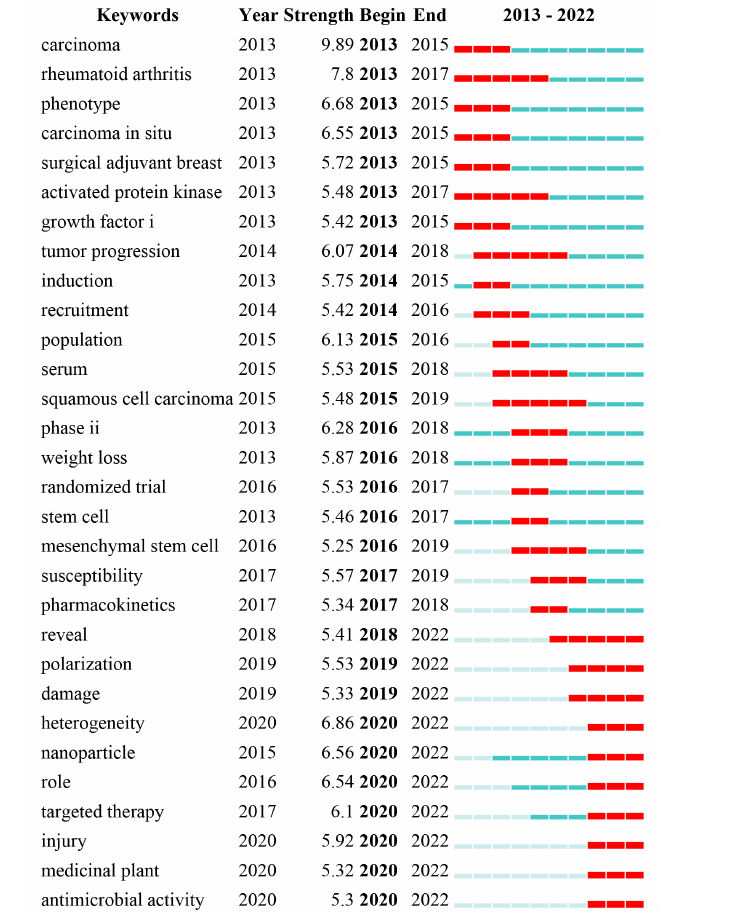
FIGURE 8 In this visualization of CiteSpace ’ s analysis of the top 30 keyword explosions, “ strong ” denotes the magnitude of the explosion, “ begin ” shows the year in which the explosion began, and “ end ” indicates the year in which the explosion ended; a red dotted line depicts the explosion ’ s length. The full time frame, from 2013 to 2022, is shown by the blue